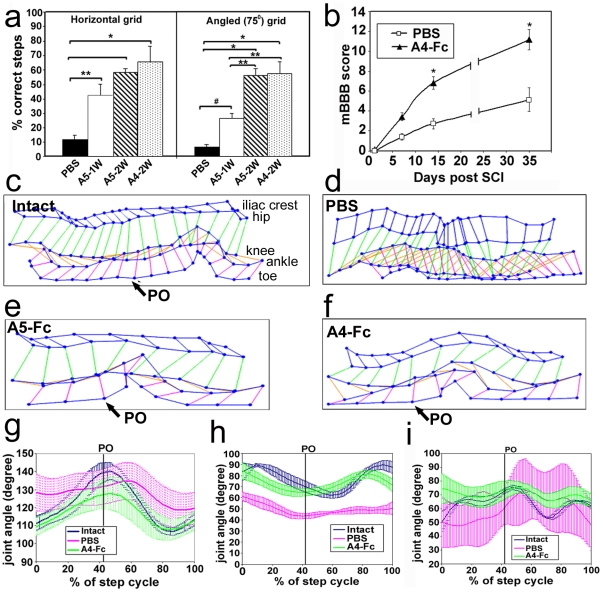
Ephrin-A5-Fc- or EphA4-Fc-treated mice show significant functional recovery 5 weeks after spinal cord injury.(A) Walking and climbing on a grid were significantly improved following 2 weeks treatment with ephrin-A5-Fc (A5-2W) or EphA4-Fc (A4-2W). One week of ephrin-A5-Fc (A5-1W) treatment resulted in significant improvement in grid walking but not in climbing as assessed by ANOVA, although it was significant by t-test (mean±SEM, *p<0.05, ***p<0.001 using one-way ANOVA with Tukey's comparison analysis; #p<0.05 using t-test). (B) The mBBB score was measured up to 5 weeks after spinal cord injury (SCI) in PBS- (n = 7) and EphA4-Fc- (A4-Fc) (n = 6) treated mice. Results show mean±SEM (***p<0.001 comparing treatment groups at the indicated time point using one-way ANOVA with Tukey's multiple comparison test). Kinematics of the left hind limb were analyzed from videotapes of locomotion of mice on the treadmill with reflective markers on the iliac crest, hip joint, knee joint and ankle joints. (C–F) Stick figures of the angles between each joint were used to depict one complete step cycle, with the beginning of the swing phase marked with an arrow for the push off point (PO) of the left hind limb and the pattern obtained for a normal intact mouse at a treadmill speed of 12 m/min (C). Panels (D–F) show a representative pattern for one mouse from each of the PBS (n = 7), ephrin-A5-Fc (A5-Fc) (n = 2) and EphA4-Fc (A4-Fc) (n = 6) groups of mice 5 weeks after spinal cord injury, at a treadmill speed of 12 m/min. Treatment over 2 weeks with ephrin-A5-Fc and EphA4-Fc resulted in approximation of the movement pattern seen in intact animals, including a phase of lifting the paw off the surface. (G–I) Average kinematic profile combined from profiles of EphA4-Fc-treated mice (n = 6), of joint angle changes over one complete step cycle of the left hip (G), knee (H) and ankle joints (I) 5 weeks after spinal cord injury in PBS- and EphA4-Fc-treated mice compared to the intact mouse pattern. The point of push off (PO) and the beginning of the swing phase is indicated by a black vertical line through the graph. Results are expressed as mean±SD.